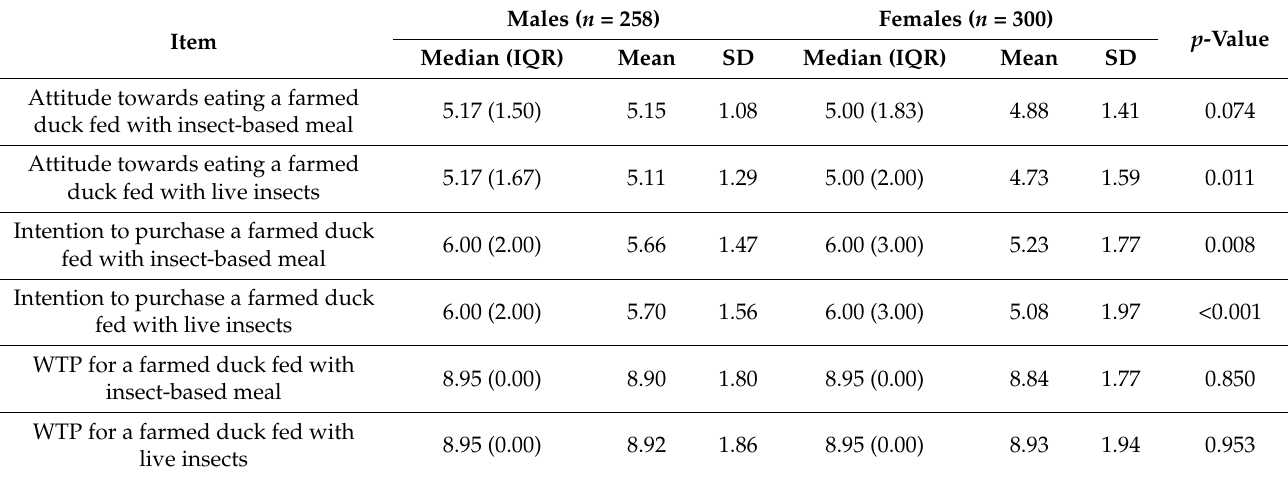
Table 3. Attitude towards, intention to purchase, and willingness to pay (WTP) for a farmed duck fed with insects between males and females (median, IQR: interquartile range; mean, SD: standard deviation; p -value for non-parametric Mann–Whitney test for independent samples).